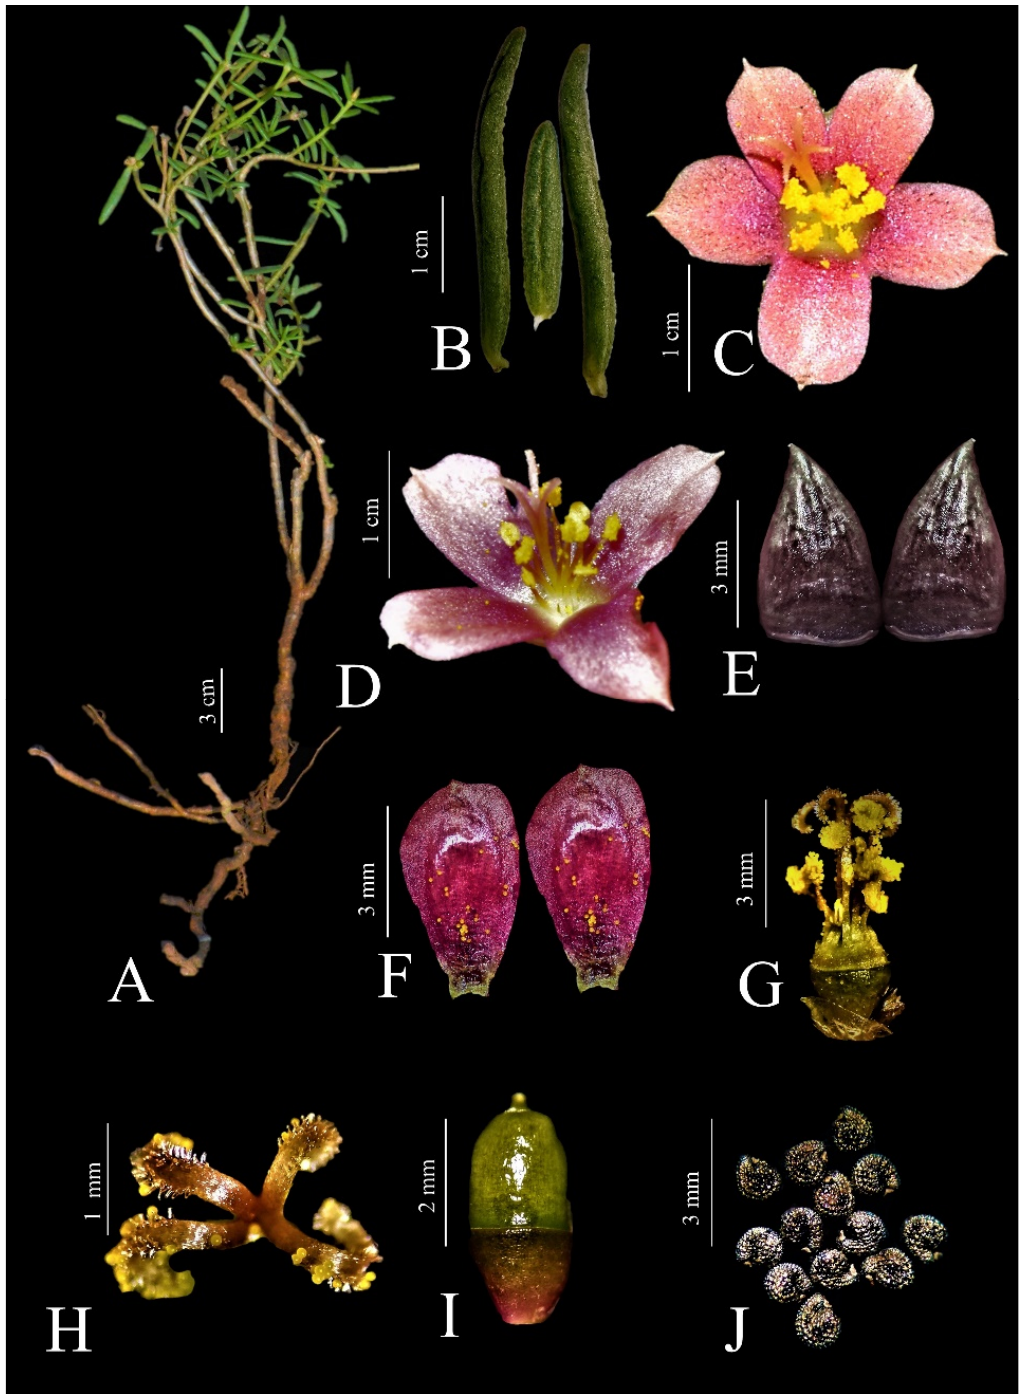
Figure 4. Portulaca lakshminarasimhaniana S.R.Yadav and Dalavi. ( A ) Habit; ( B ) leaves; ( C , D ) flowers; ( E ) sepals; ( F ) petals; ( G ) gynoecium with staminal column; ( H ) stigma; ( I ) pyxis; ( J ) seeds. Type: INDIA, Karnataka, Bagalkot District, Badami, 611 m a.s.l., 15.918955 E,